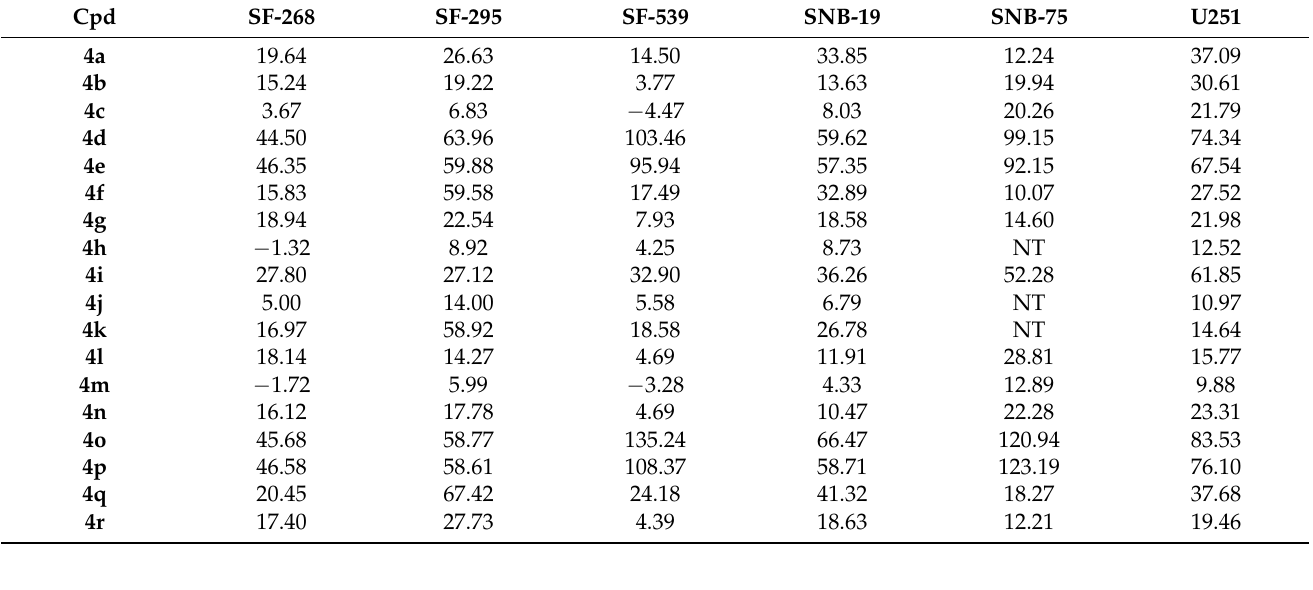
Table 8. Anti-proliferative activities (% growth inhibition) of the target compounds 4a – r against CNS cancer cell lines.